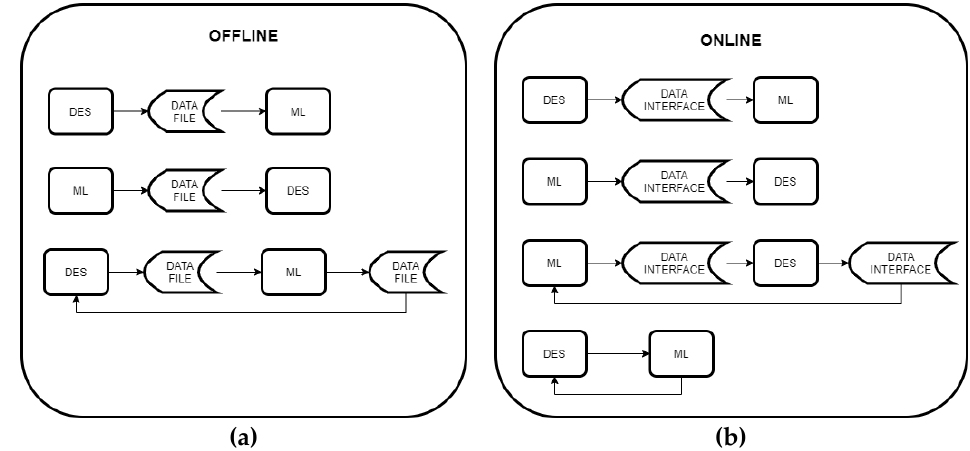
Figure 4. Various architectures for combining COTS DES and ML software, classified as ( a ) offline, and ( b ) online. (adapted from Greasley [34]).